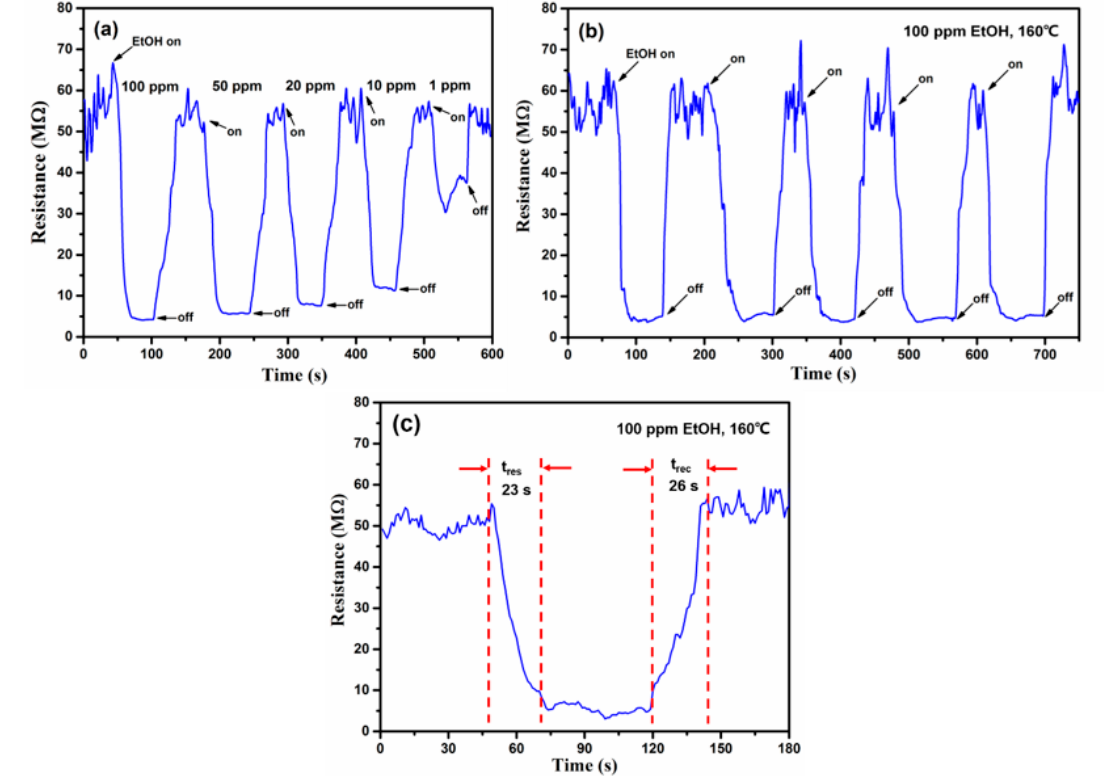
Figure 10. Gas sensing performance of SnS nanosheets: ( a ) Dynamic sensing performance of SnS nanosheets toward EtOH gas at concentrations ranging from 1 ppm to 100 ppm at 160 ◦ C. ( b ) Five reversible test cycles of SnS nanosheets toward 100 ppm EtOH at 160 ◦ C. ( c ) A single cycle test of SnS nanosheets after exposure to 100 ppm EtOH at 160 ◦ C.